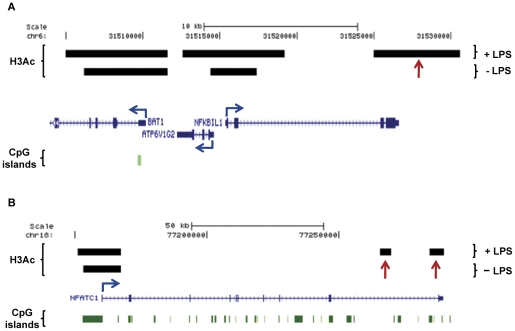
LPS treatment and the appearance of unique H3Ac peaks.
NFKBIL1 and NFATC1 are examples of genes having common H3Ac peaks in both +/−LPS conditions. They also have unique H3Ac peaks that appear upon LPS stimulation (indicated with red arrows). (2A) A unique H3Ac peak appears at the 3′ end of NFKBIL1 after LPS stimulation. (2B) For NFATC1 two unique H3Ac peaks appear, these are located at the intronic and 3′end region, respectively. Genes identified by RefSeq using the UCSC browser are shown with blue arrows indicating TSSs locations and directions (GRCh37/hg19).